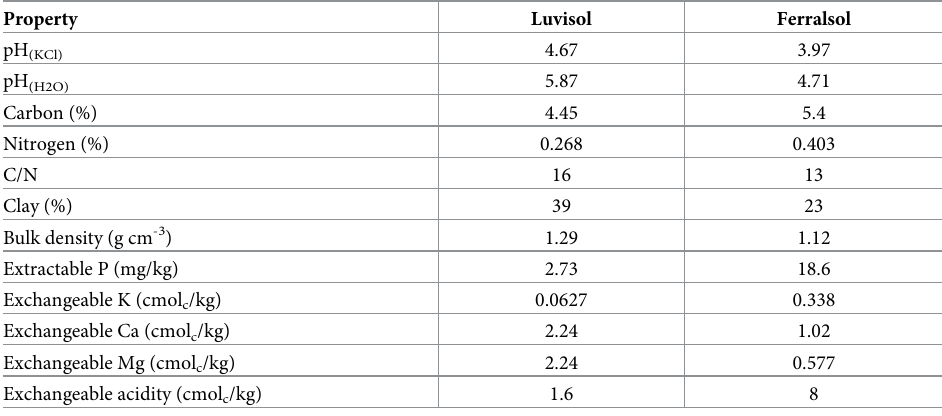
Table 2. Selected physico-chemical properties of the soil